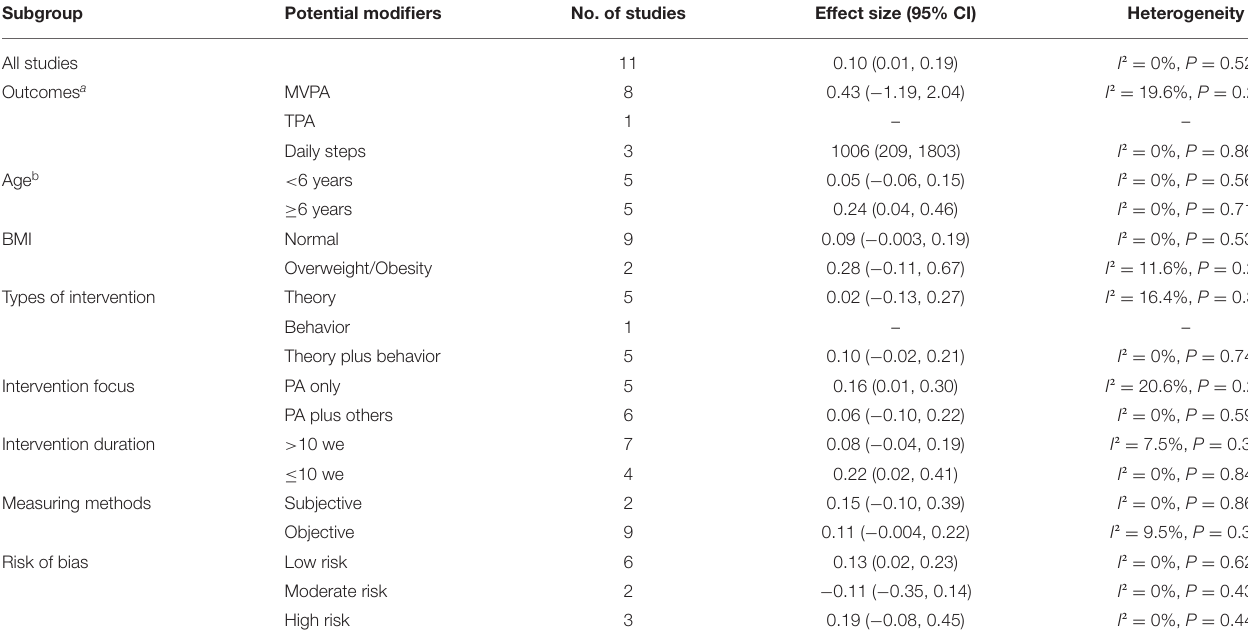
TABLE 2 | Subgroup analysis of the effect of the family intervention on